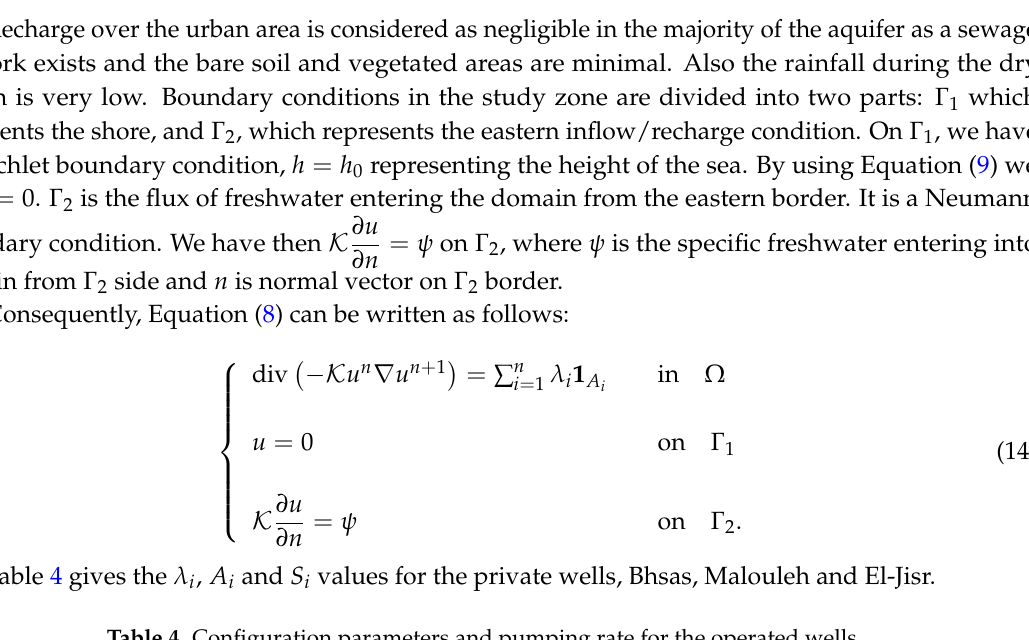
Table 4. Configuration parameters and pumping rate for the operated